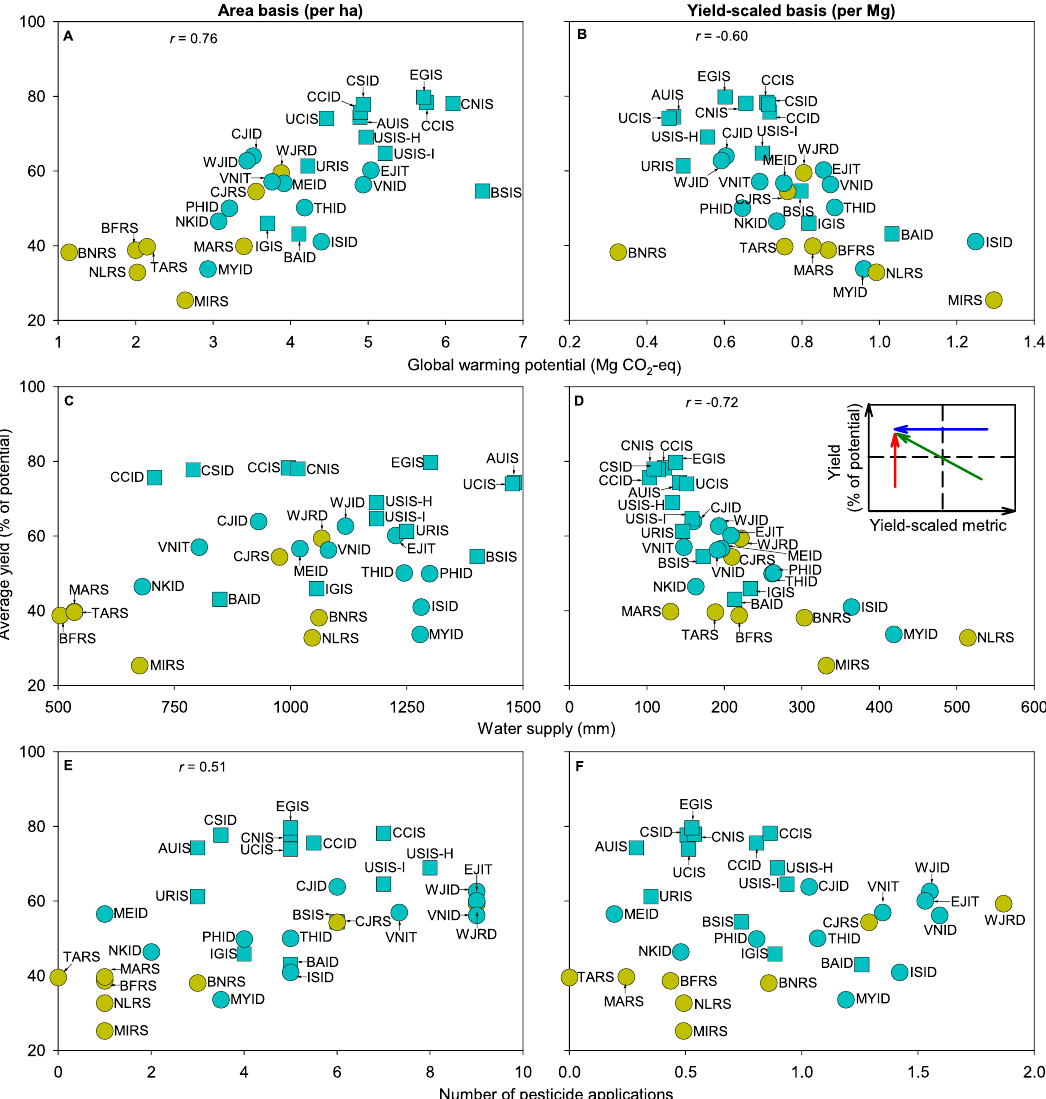
Fig. 2 Yield, global warming potential, water supply, and number of pesticide applications on both area and yield-scaled basis across 32 rice cropping systems. Panels show average rice yield (expressed as percentage of yield potential) versus A , B global warming potential, C , D water supply (irrigation plus in-season precipitation), and E , F number of pesticide applications. Global warming potential, water supply, and number of pesticide applications are shown on an area ( A , C , E ) or yield-scaled basis ( B , D , F ). Each point represents the average for the rice crops in each cropping system (typically two or three for irrigated rice in tropical regions and one or two for rainfed rice in tropical regions and for irrigated rice in non-tropical regions). Symbol type and color are used to distinguish tropical versus non-tropical regions (circles and squares, respectively) and irrigated versus rainfed systems (blue and yellow, respectively). Inset in D shows hypothetical pathways to improve yield and/or reduce environmental impact. Pearson ’ s correlation coef fi cient ( r ) is shown only when the association between variables is signi fi cant (two-tailed Student ’ s t -test; p < 0.01; n = 32 cropping systems). Cropping system codes are shown in the caption to Fig. 1. Data are provided in Source